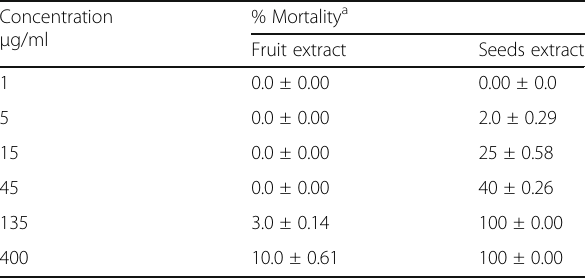
Table 1 Developmental toxicity (lethality) of fruit and seeds extract of M. charantia in zebrafish embryos Concentration % Mortality a μ g/ml Fruit extract Seeds